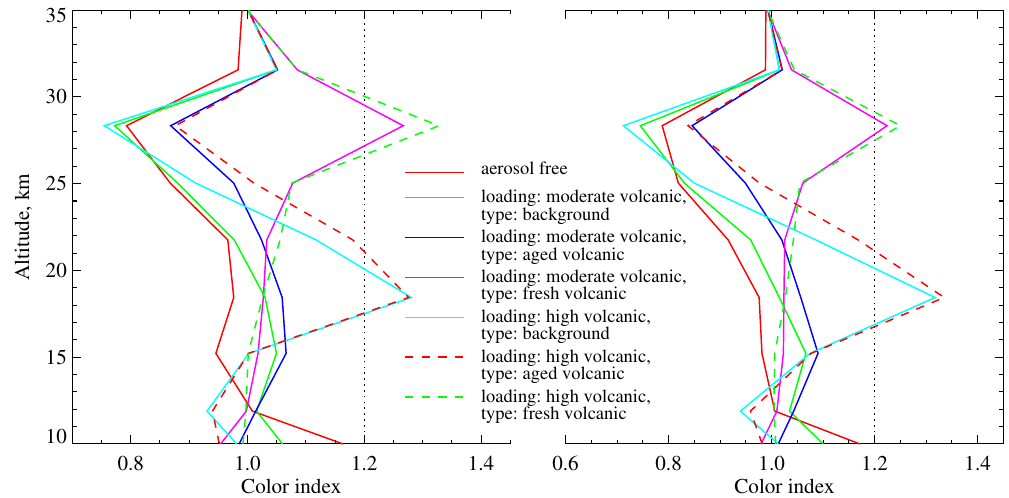
Fig. 16. Color index (1090 to 1552nm) for different aerosol scenarios. Left panel: a typical tropical measurement. Right panel: an observation geometry typical for winter season at high-latitudes of the Northern Hemisphere. Dashed lines show the cloud detection threshold that is currently used in the SCODA algorithm.